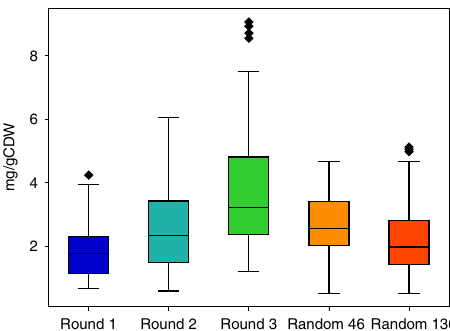
Fig. 4 Lycopene production in different rounds of pathway optimization and random screening. The average and maximum points have increased after each round of pathway optimization. Moreover, although the average and maximum of evaluating 46 and 136 random points are a little more than the uniform distribution in round 1, they are signi fi cantly lower than the points picked by the algorithm in the subsequent rounds. The boxes of the plots contain data within the interquartile range (IQR), while whiskers spread from the boxes to 1.5 times IQR. The center line in the boxes is the median of the data and points above the whiskers are values which are higher than 1.5 times IQR above the third quartile. n = 46, 45, 45, 46 and 136 for each plot, respectively. Source data are provided as a Source Data fi